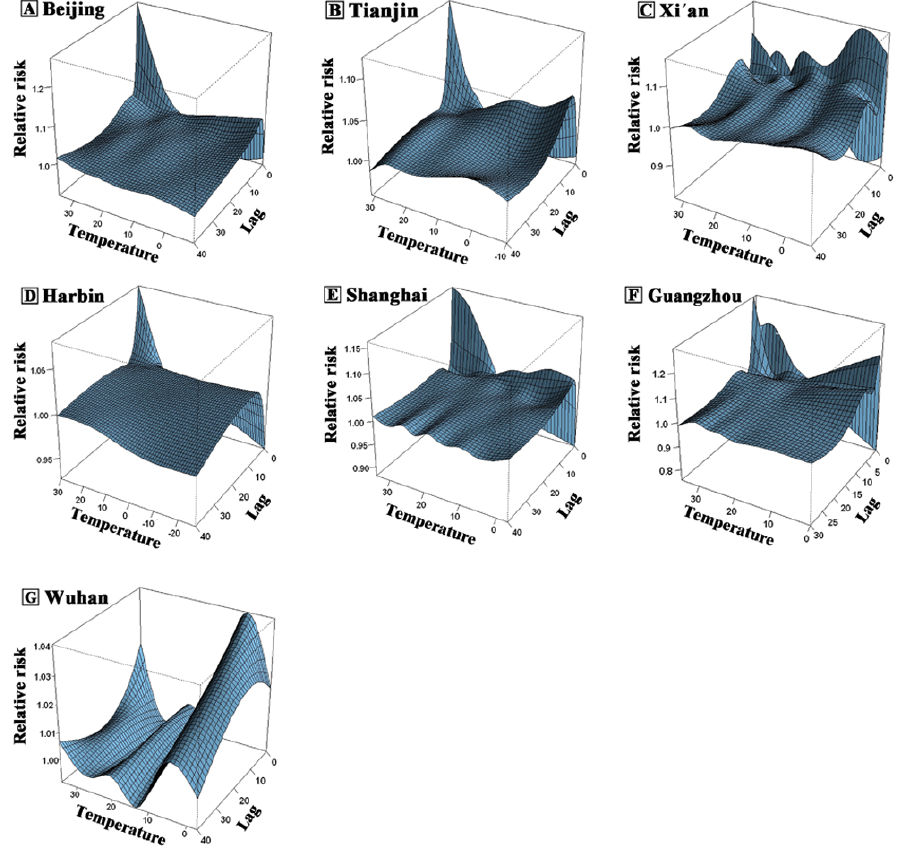
Figure 2. Three-dimensional plot of relative risk (RR) along temperature and lags on